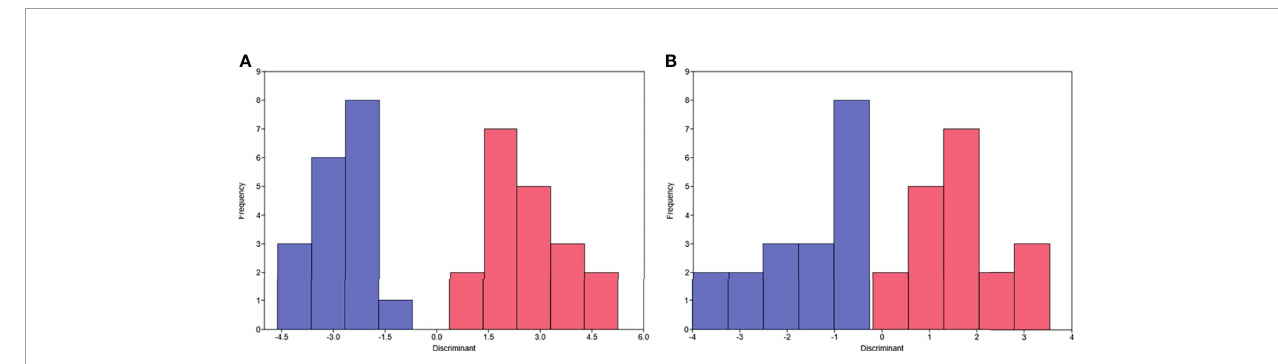
FIGURE 2 | Linear discriminant analysis (LDA) of progression-free survival based on the changes of proteins in plasma after the second treatment cycle. (A) LDA based on the changes of 25 proteins. (B) LDA based on the changes of 7 proteins. Pink, durable responders; Blue, non-durable